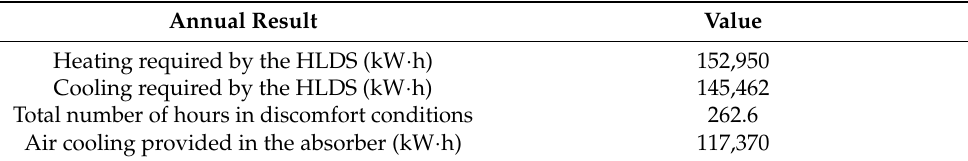
Table 7. Annual results of the HLDS working in the optimized working conditions.